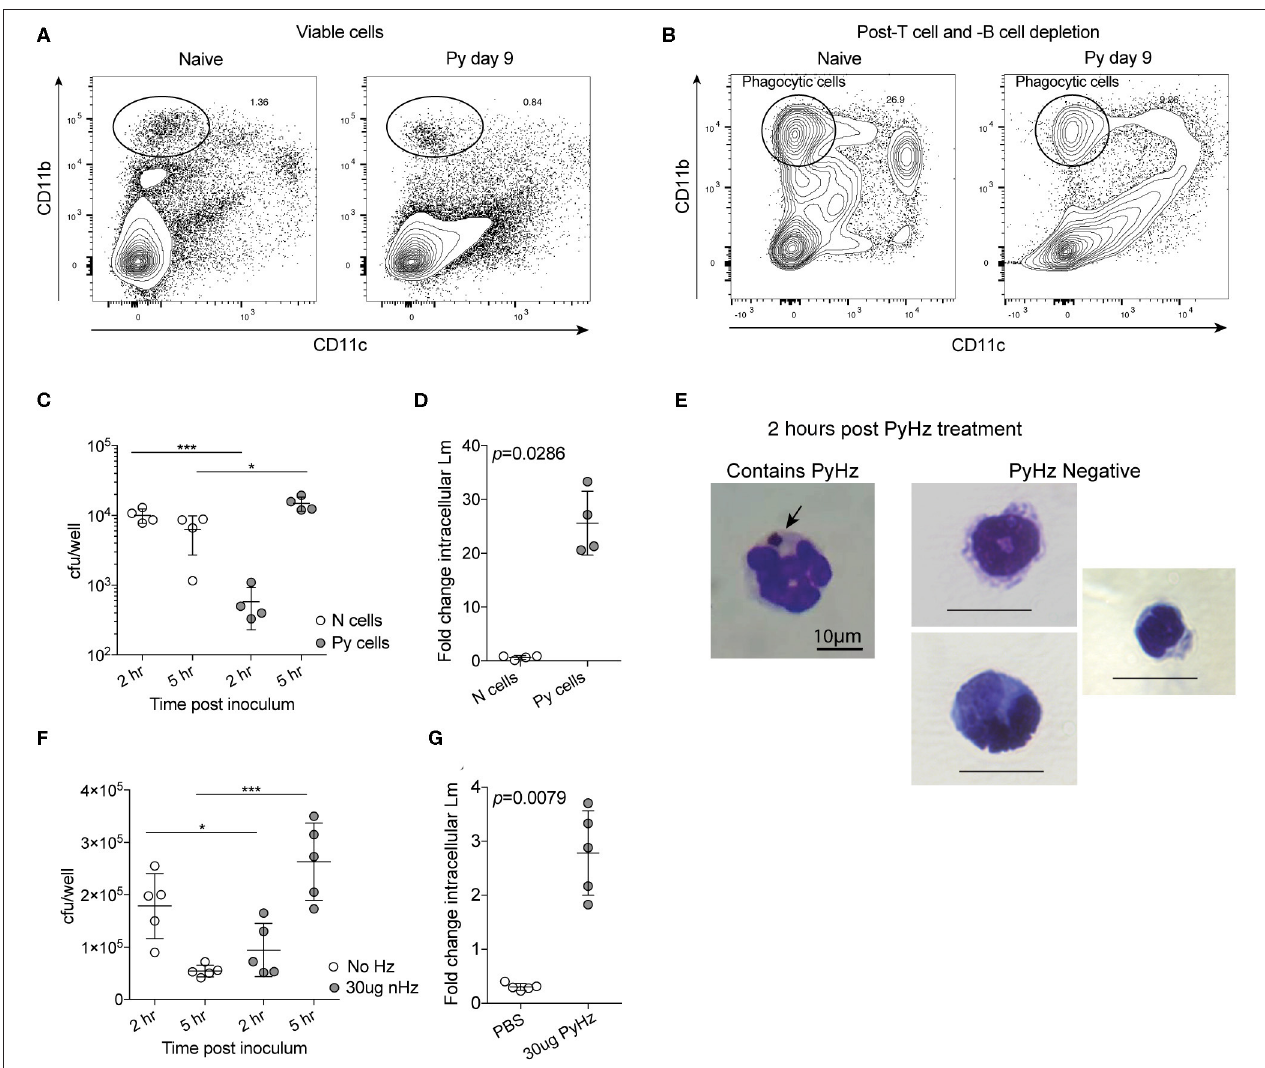
FIGURE 7 | P. yoelii infection and parasite-derived hemozoin impairs anti-bacterial functions of splenic phagocytes. (A–C) After C57BL/6N mice were infected with 10 5 Py pRBCs, splenic phagocytes were enriched from naïve or Py-infected mice day 9 post Py. Magnetic columns were used to enrich for splenic phagocytes by negative selection of CD3 + CD19 + cells. (A) Contour plot showing CD11b and CD11c expression on viable splenocytes prior to T and B cell depletion on magnetic column. (B) Contour plot showing CD11b and CD11c expression on splenocytes following magnetic column depletion of T and B cells. Circle indicates the population of splenic phagocytes that was sort purified for gentamicin protection assays. CD11b hi CD11c − cells were then sort purified for experiments. (C,D) 10 5 sort-purified CD11b hi CD11c − splenic phagocytes were plated in each well and infected with Lm opsonized with homologous mouse serum with MOI = 100. Intracellular Lm burden was determined after 2 and 5h (C) in a gentamicin protection assay to evaluate fold change at 5h post infection (D) . Fold change in intracellular bacteria was determined by cfu/well at 5h post infection divided by cfu/well at 2h post infection. (E–G) 10 5 sort-purified CD11b hi CD11c − splenic phagocytes were enriched, as in (A,B) , from naïve mice and were incubated with 30 µ g hemozoin purified from spleen and livers of mice previously infected with Py (PyHz). (E) A giemsa-stained cell containing internalized PyHz (brown pigment), indicated by arrow, and PyHz negative cells containing no visible uptaken pigment. Intracellular Lm burden was determined after 2 and 5h (F) in a gentamicin protection assay to evaluate fold change at 5h post infection (G) . Fold change in intracellular bacteria was determined by cfu/well at 5h post infection divided by cfu/well at 2h post infection. Data (mean ± S.D.) are representative of three independent experiments each symbol represents an individual replicate of pooled cells from three mouse spleens per group (naïve or Py-infected). Statistical analysis was determined with Mann-Whitney test. * p < 0.05 and *** p <